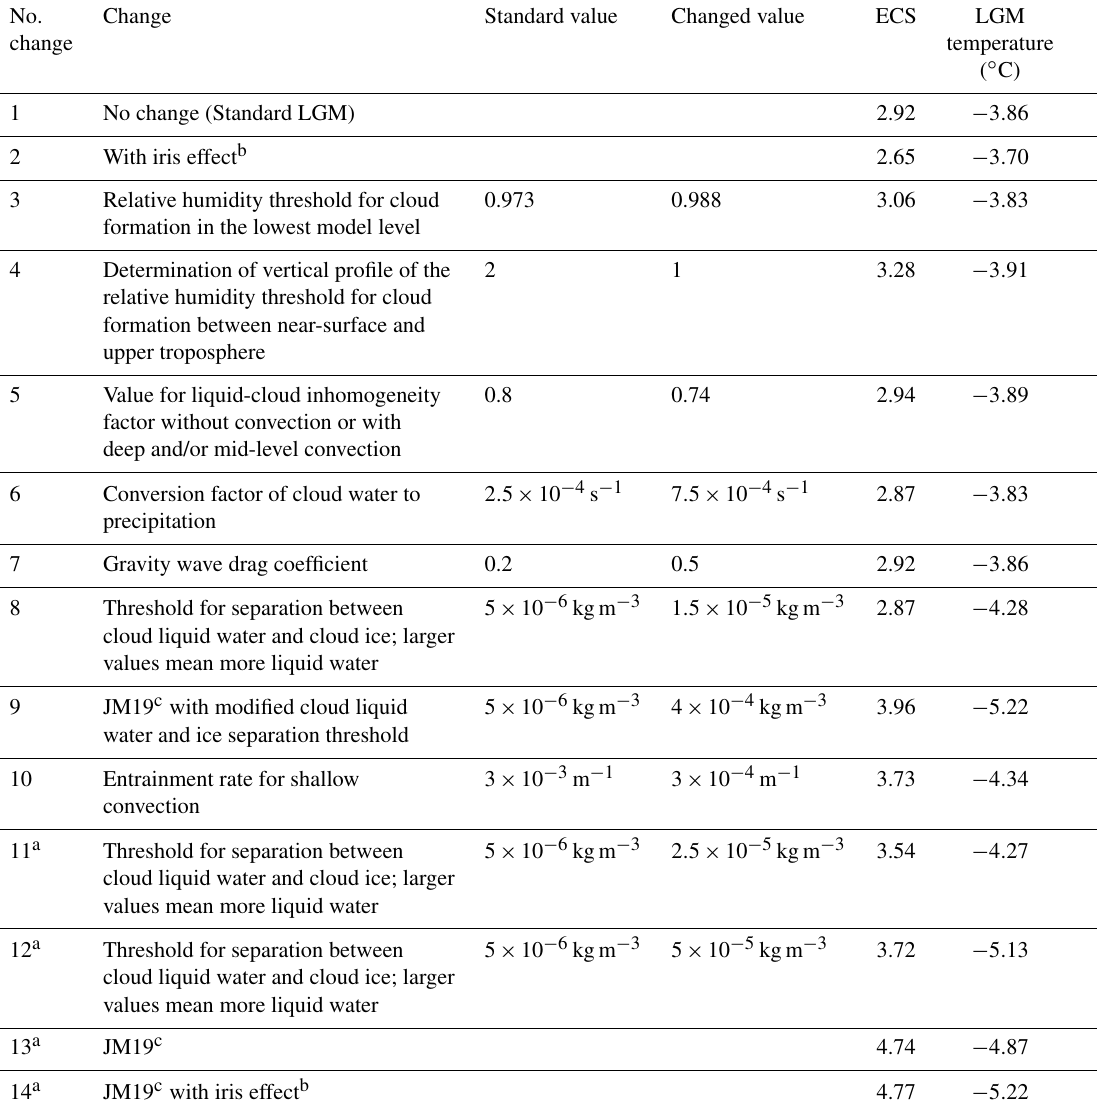
Table 2. Summary of the simulations of the single-model ensemble of MPI-ESM1.2-LR. a Unstable runs, where the temperature is an estimate of the last 50 years before numerical crash. b Iris effect implementation of Mauritsen and Stevens (2015). c JM19 refers to runs with all the changes in the table as well as an increase in the relative humidity threshold for cloud formation at high model level, a decrease in entrainment rate in shallow convection and a decrease in minimum excess buoyancy, as described by Jiménez-de-la Cuesta and Mauritsen (2019). No. Change Standard value